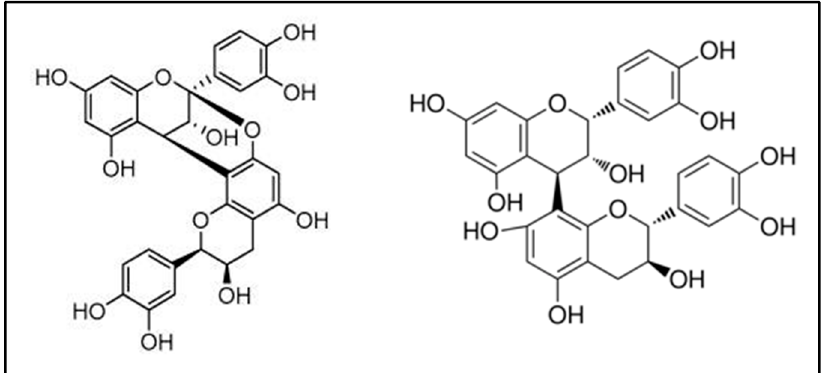
Figure 2. Proanthocyanidin A-type ( left ) and B-type ( right ).